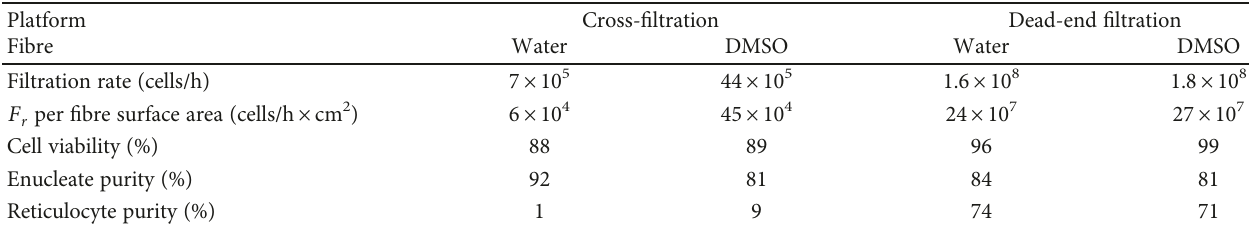
Table 2: Filtrate collected within 6 hours of cross- fl ow and dead-end fi ltration for water and DMSO fi bre types. Filtration rate, viability, and enucleated fraction were assessed by manual cell counting on a hemocytometer using trypan blue or methylene blue dye exclusion. Reticulocyte purity was measured by fl ow cytometry and corresponded to a calcein AM-positive, Hoechst-negative, and CD235a-positive